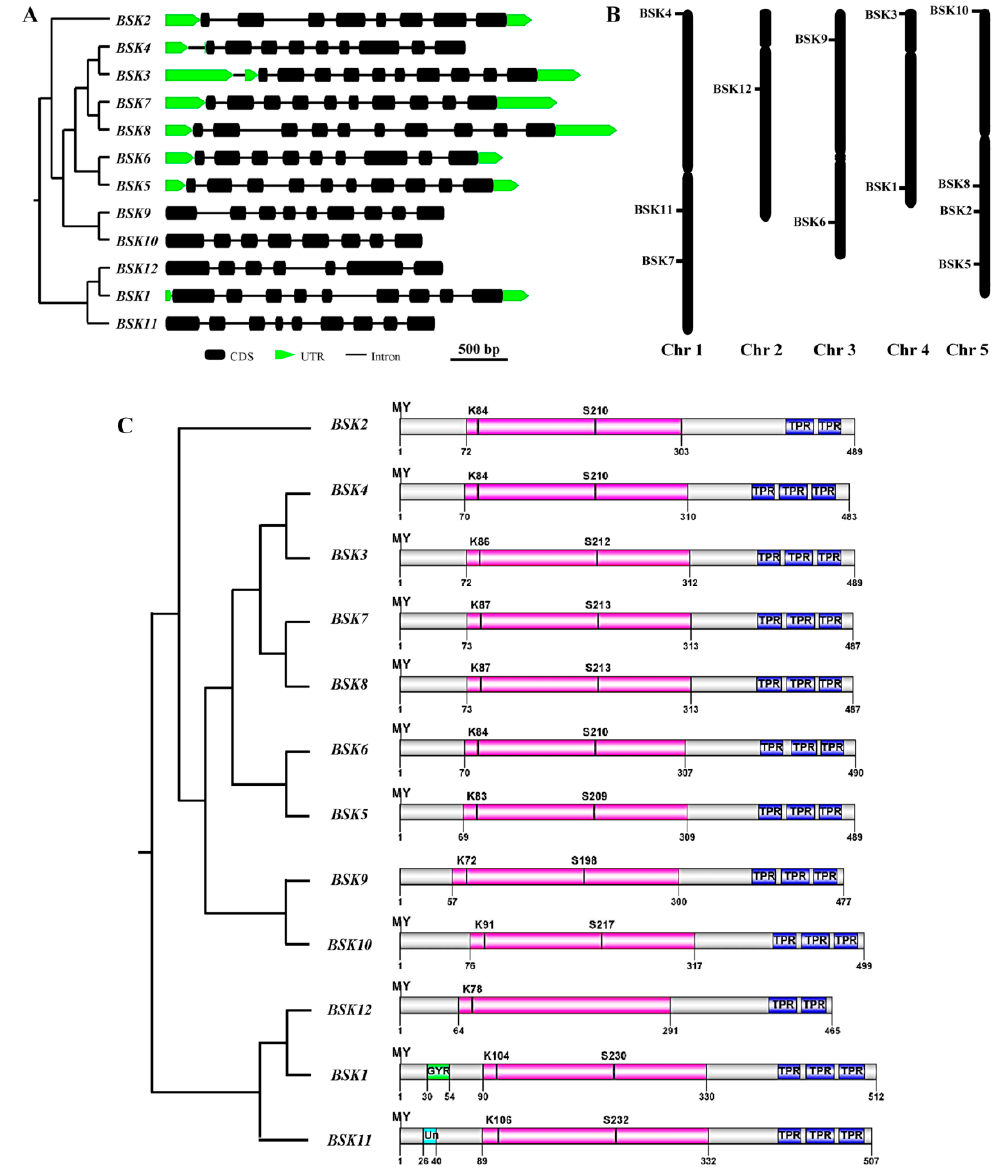
Figure 4. The features of the BSK genes in Arabidopsis . ( A ) Exon-intron structures of the BSK family genes. ( B ) Chromosomal location of BSK genes. ( C ) Schematic diagram of Arabidopsis BSK genes. The putative domains or motifs were identified using the Conserved Domain Database (CDD), Pfam and Simple Modular Architecture Research Tool (SMART) databases with the default parameters. The kinase domain was labeled in pink. MY, myrislation; TPR: tetratricopeptide repeat; GYR: glycine rich domain; Un: unknown domain.